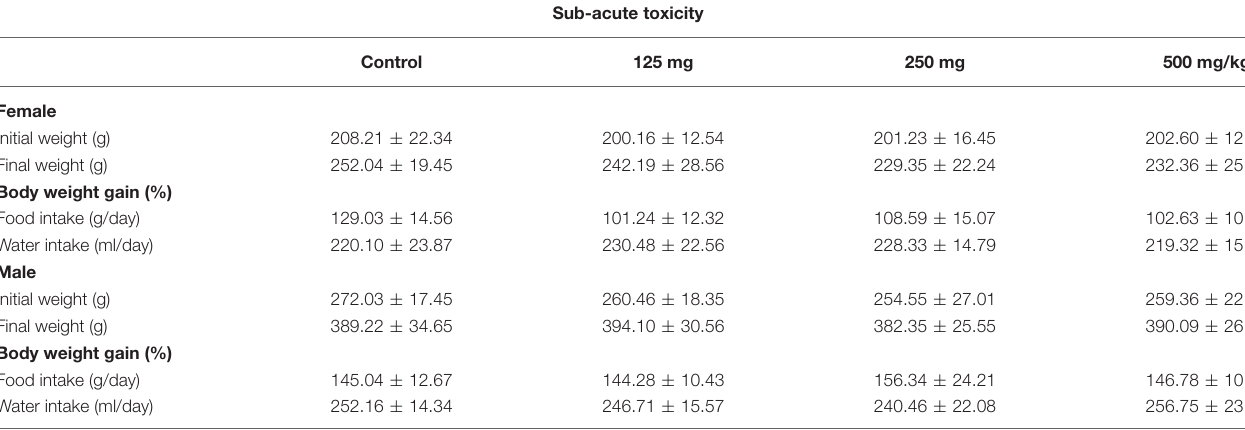
TABLE 1 | Effect of fungal taxol on body weight changes and food and water intake in control and treated Wistar rats in the sub-acute toxicity study.